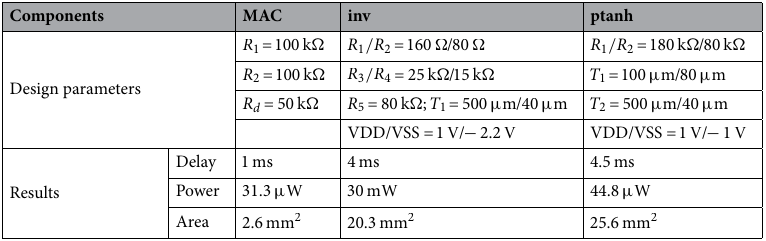
Table 2. Design parameters and result metrics of hardware prototypes. Resistance values R i , R d are indicated, also the supply voltages VDD/VSS and the printed transistor channel geometries T i